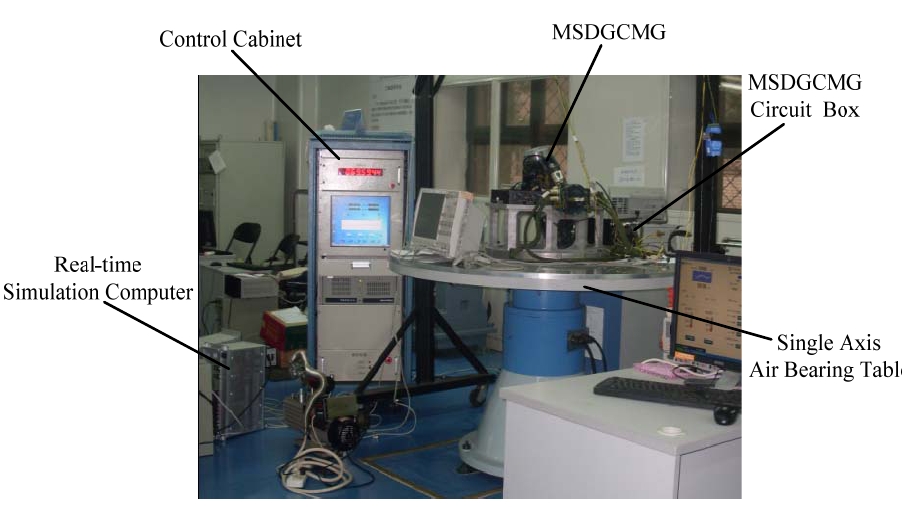
Figure 3. Experiment Scene of Semi-Physical